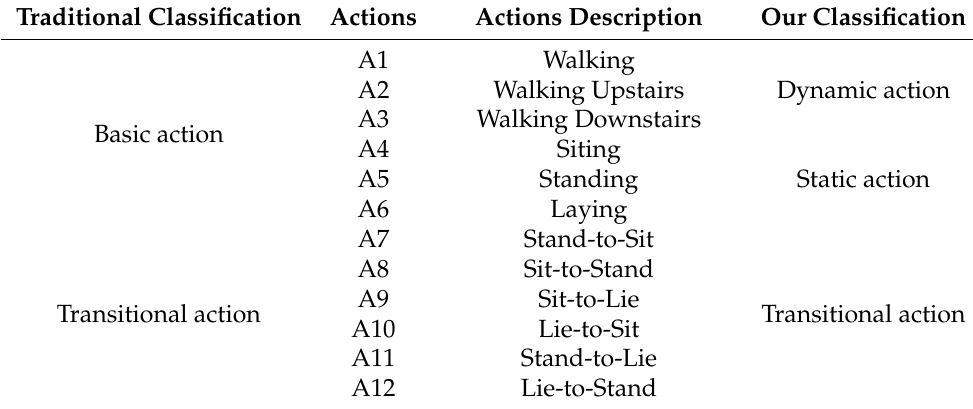
Table 2. Human daily